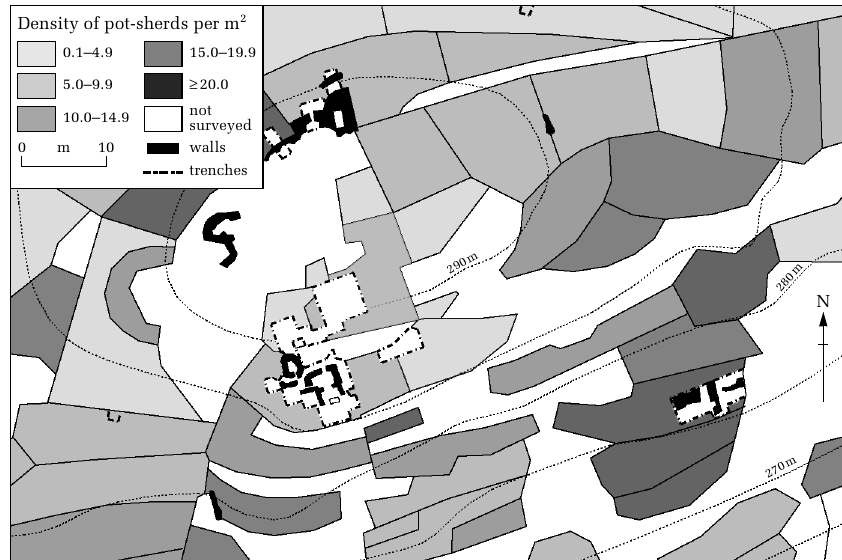
Figure 4 Plan of the site at Markiani, Amorgos, showing excavation trenches, Early Bronze Age walls, and the surface density of pot-sherds.